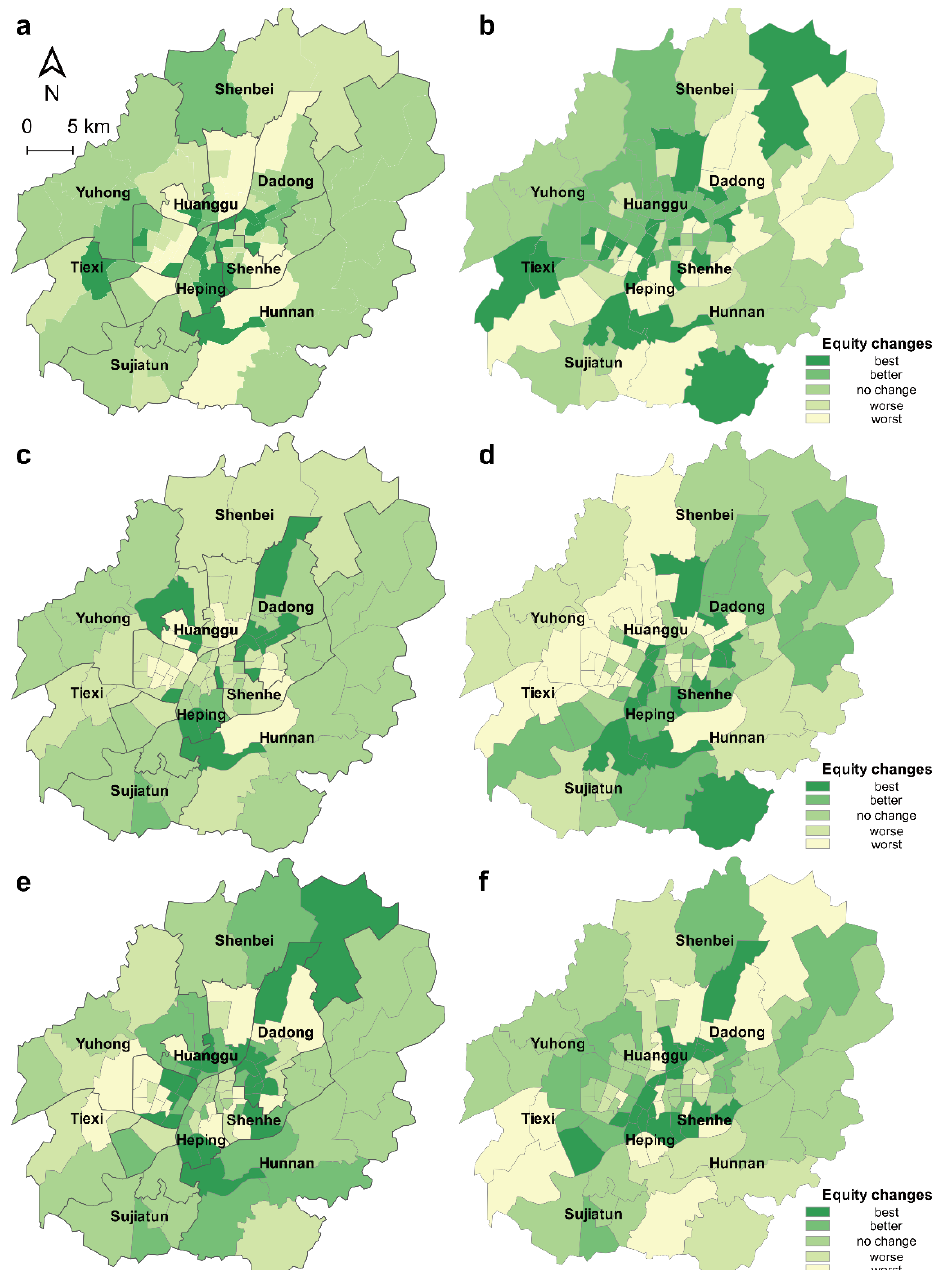
Figure 10. Variations in equity of accessibility to healthcare services during development of subway system: ( a ) changes in equity of access quantity after introduction of metro lines 9 and 10; ( b ) changes in equity of access quantity after introducing metro lines 3, 4, and extension lines; ( c ) changes in equity of access quality after introducing metro lines 9 and 10; ( d ) changes in equity of access quality after introducing metro lines 3, 4, and extension lines; ( e ) changes in equity of walking access after introducing metro lines 9 and 10; ( f ) changes in equity of walking access after introducing metro lines 3, 4, and extension lines.